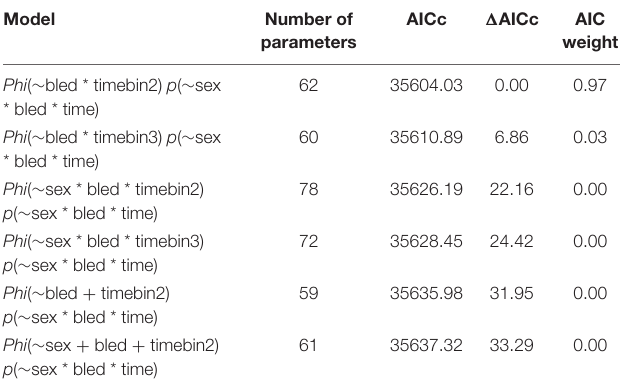
TABLE 5 | Statistics for the top 6 candidate models fit to the capture histories for horseshoe crabs tagged in coastal Delaware to Virginia (cf Figure 1 ) from 2008 to 2017.